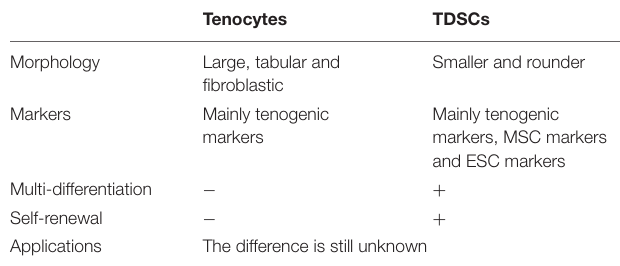
TABLE 3 | Summary of general comparisons between tenocytes and